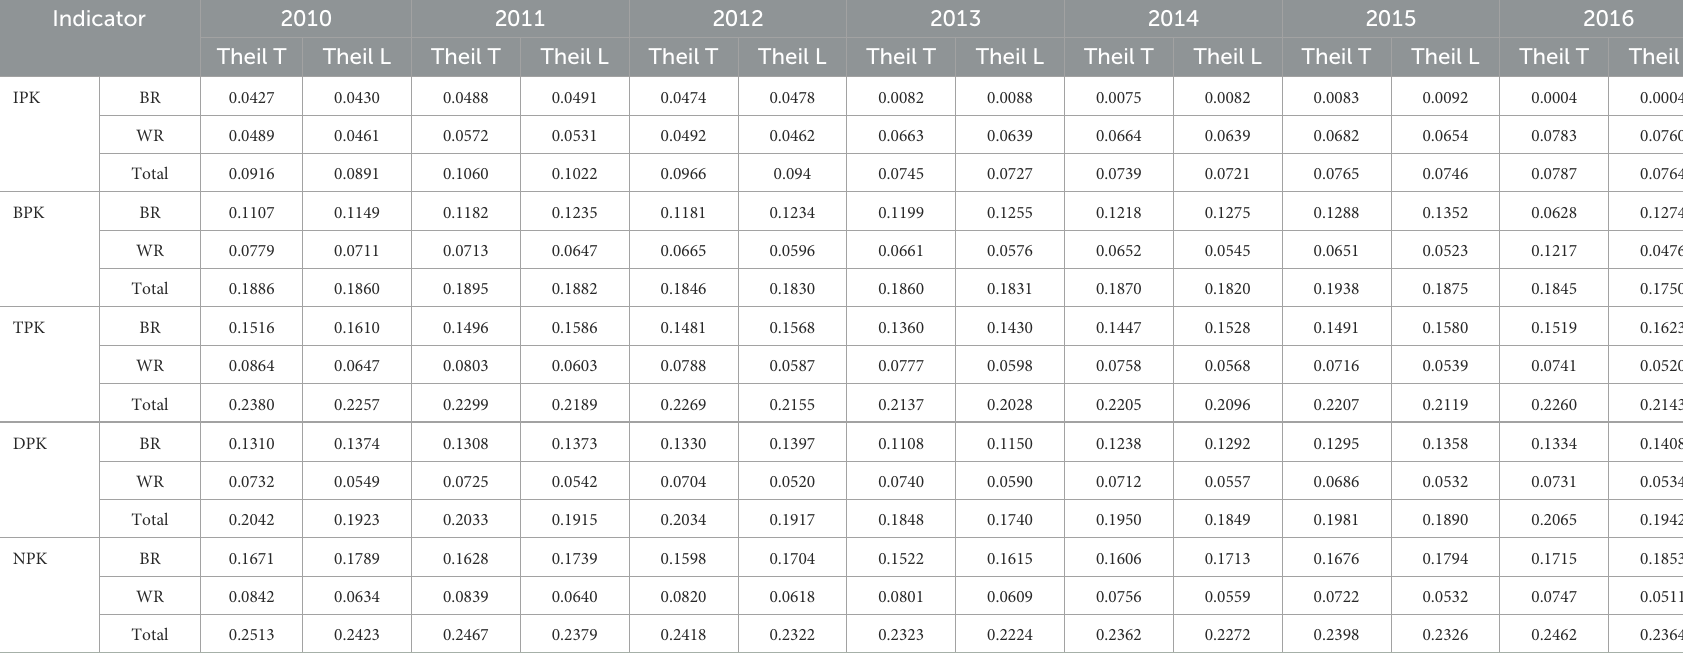
TABLE 3 The trends of Theil indices and their decomposition for the health resources in Shanghai from 2010 to